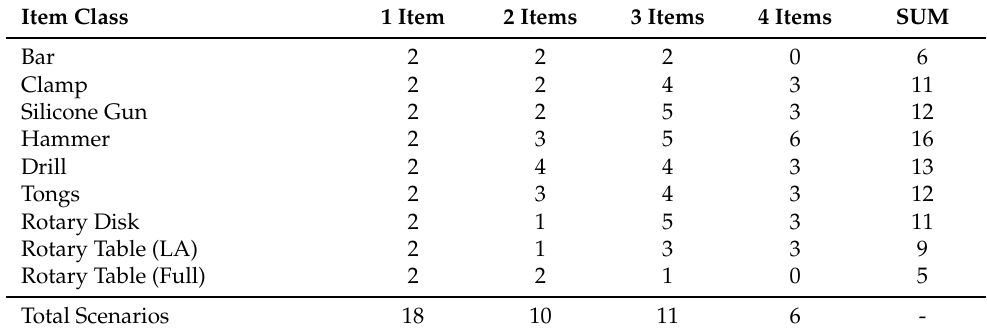
Table 3. Composition of validation scenarios with item classes and their appearance per scenario.